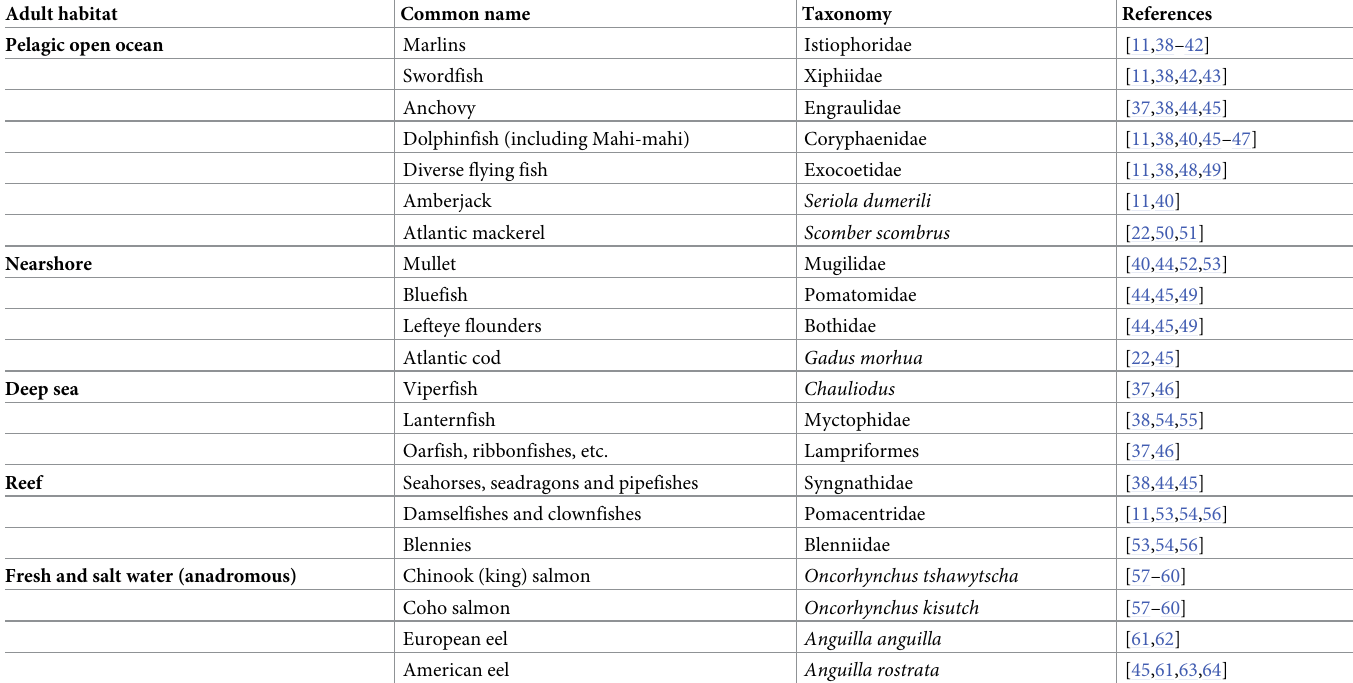
Table 1. Select fish species that depend on the ocean’s surface for food or egg/larval